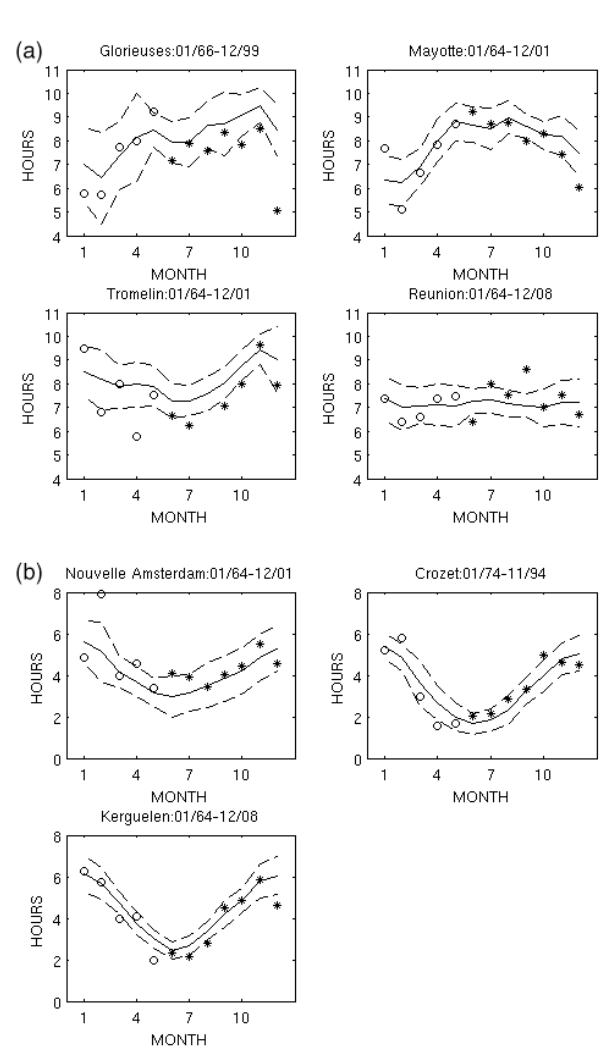
Figure 7. Same as Fig. 5 but for sunshine duration.